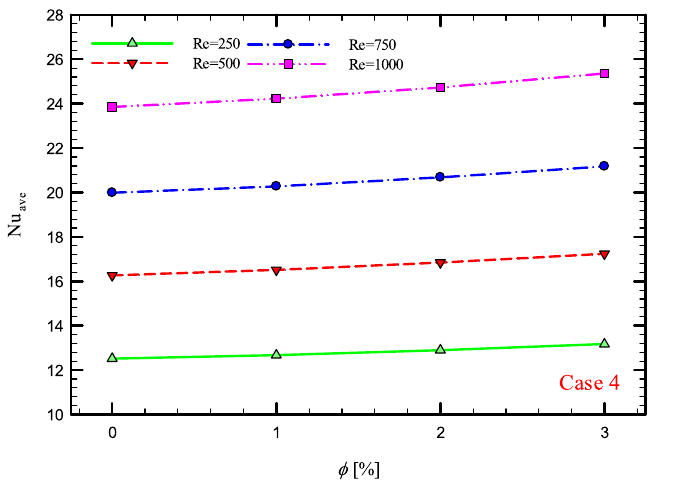
Figure 24. Nu ave versus φ for Case 4.